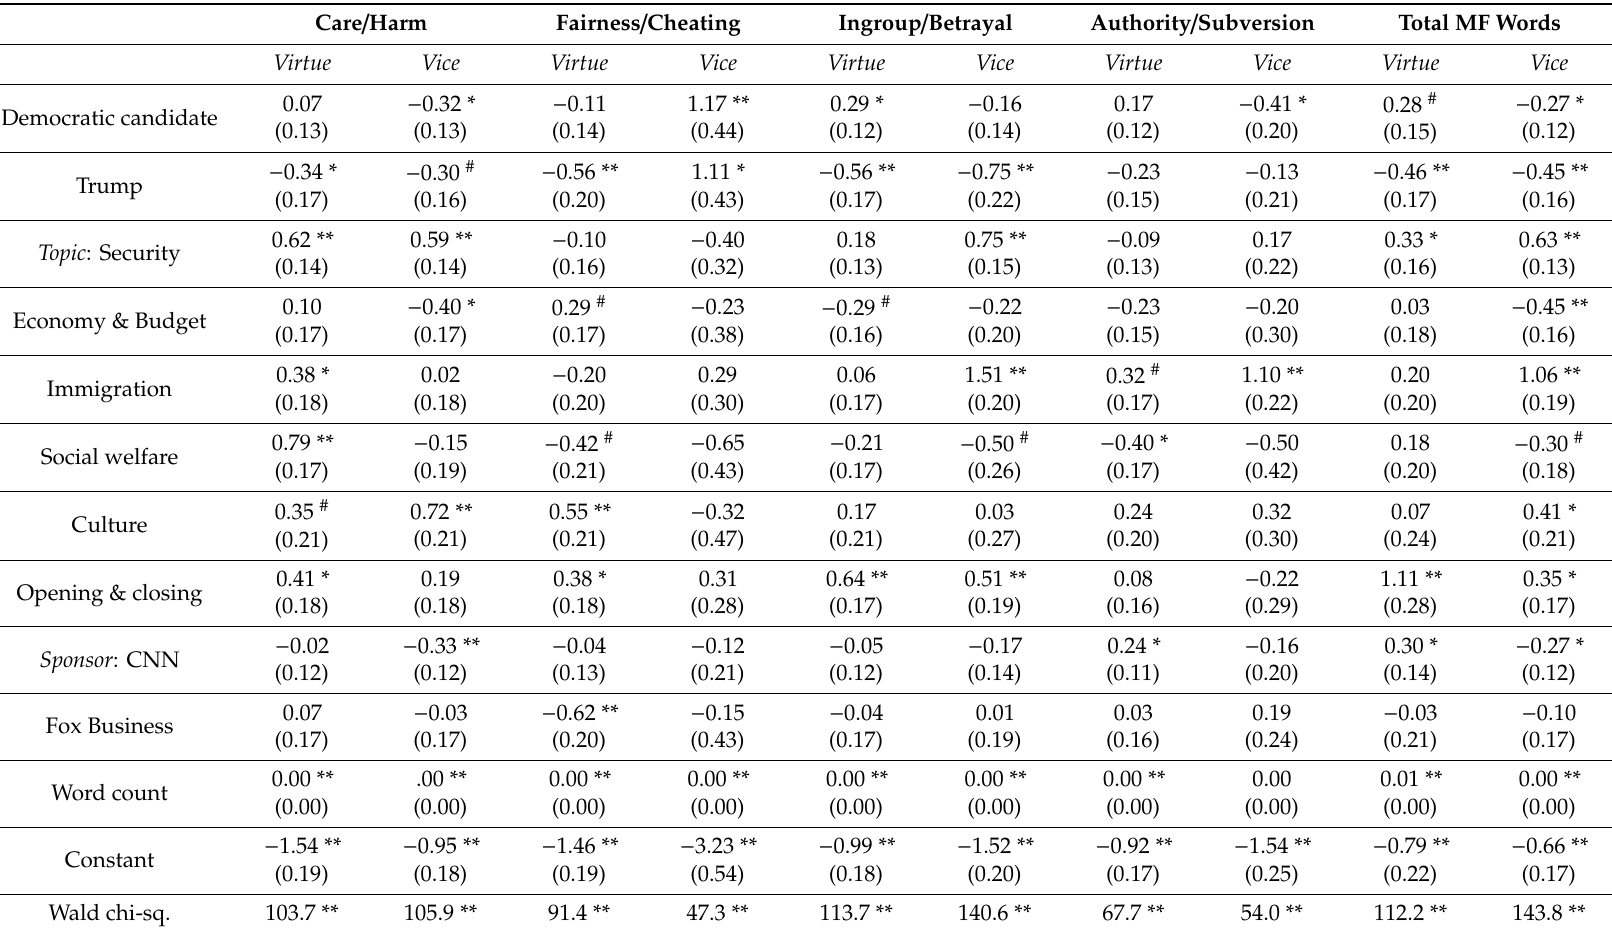
Table A2. Probit regressions estimating the presence of any moral-foundations